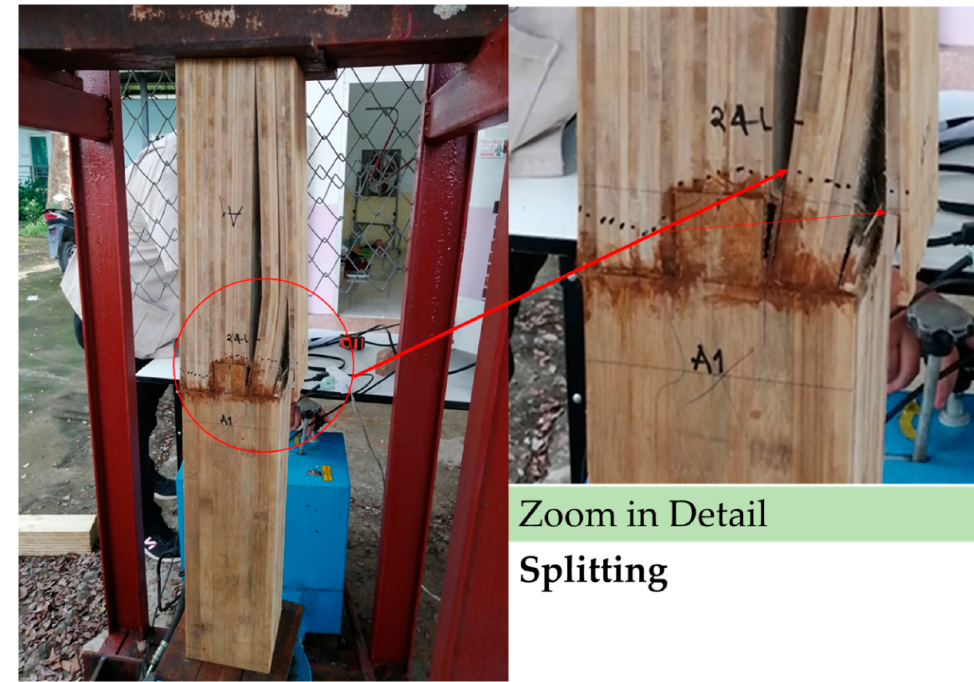
Figure 6. Splitting mode.